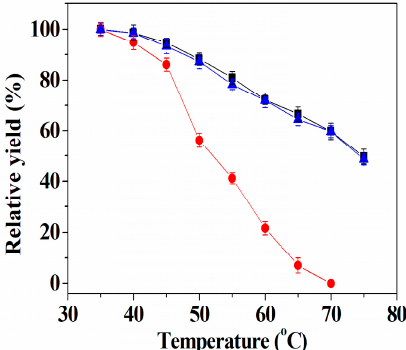
Figure 6. The effect of heat incubation on the DFF yield of co-immobilized tri-enzymes ( ■ ), separately immobilized tri-enzymes ( ▲ ) and free tri-enzymes ( ● ). Reaction conditions: 35 mg of co-immobilized tri-enzymes or 105 mg of separately immobilized tri-enzymes (containing 35 mg of immobilized galactose oxidase, 35 mg of immobilized catalase and 35 mg of immobilized horseradish peroxidase) or free tri-enzymes (20 U of galactose oxidase, 8000 U of catalase and 500 U of horseradish peroxidase); 200 mM of HMF; Tris-HCl buffer (50 mM, pH 6.6) for co-immobilized tri-enzymes and separately immobilized tri-enzymes, and Tris-HCl buffer (50 mM, pH 7.1) for free tri-enzymes; at 37 °C.